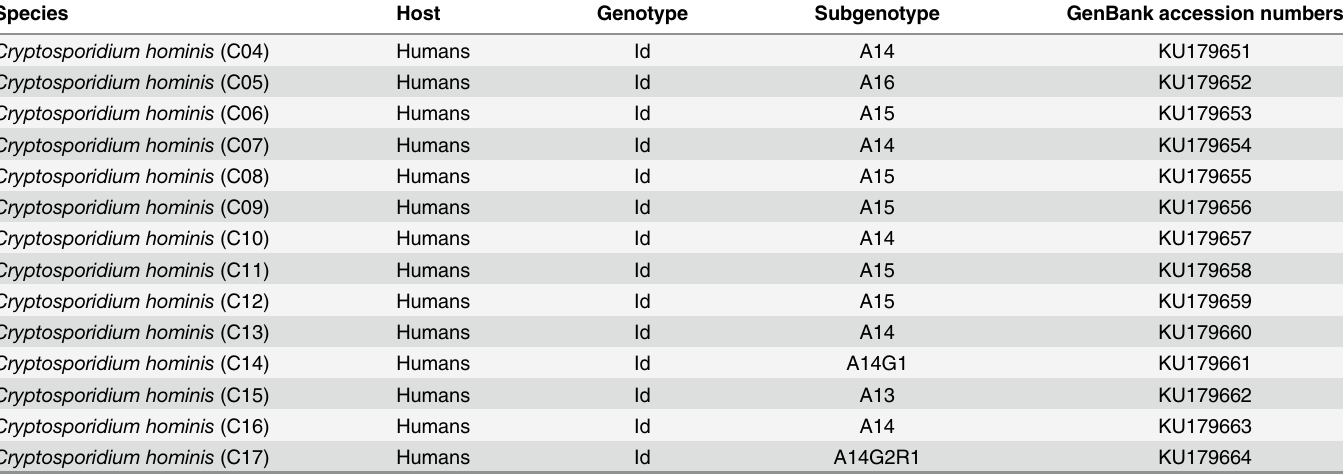
Table 3. GeneBank accession numbers of gp60 gene of Cryptosporidium hominis subtypes isolated from patients with diarrhea in the present study.